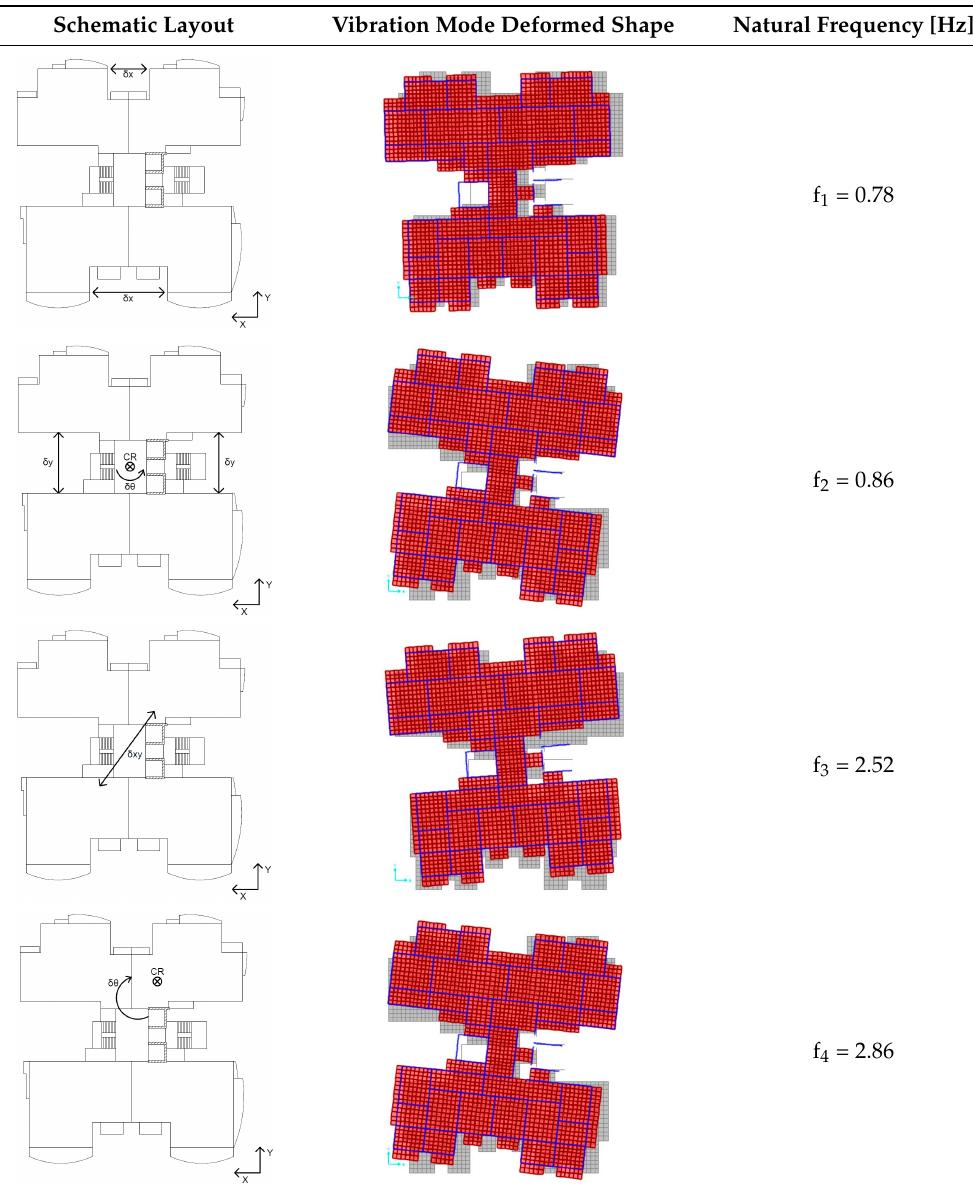
Table 4. Modal analyses results: model with undamaged infill masonry walls.